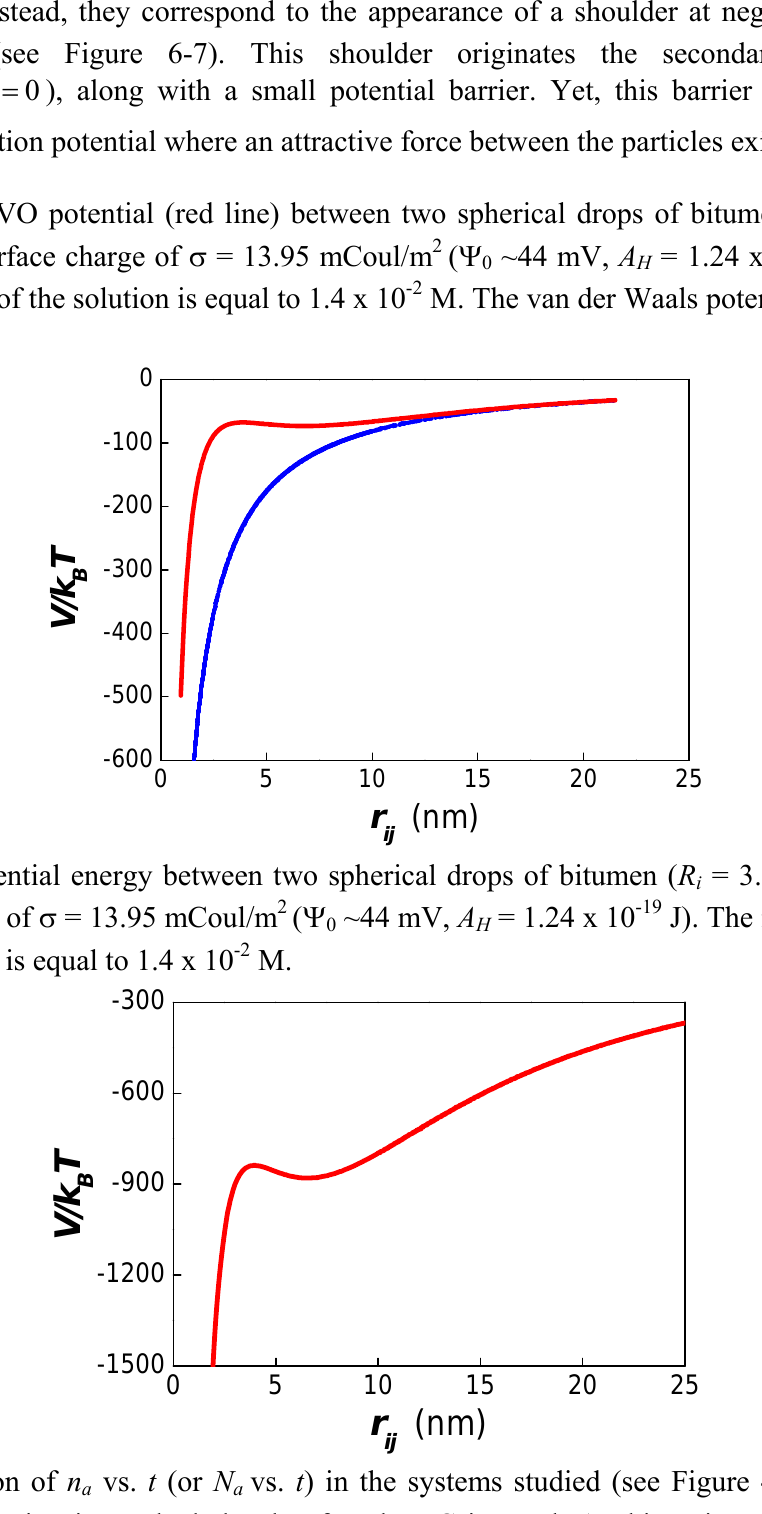
= 0.39 i ~44 mV, A = 1.24 x 10 -19 J). The 0 H